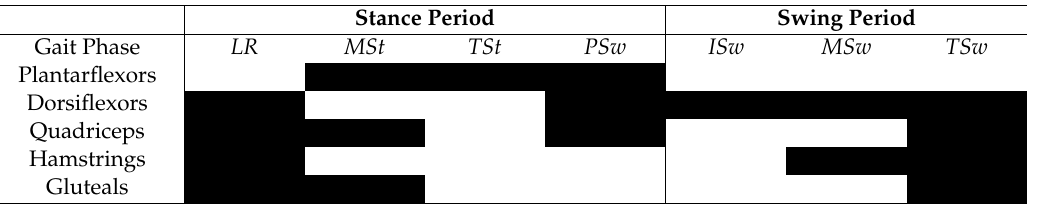
Table 1. Stimulation program based on typical muscle firing patterns during gait [30]. Black boxes illustrate when the muscle groups were stimulated during the gait cycle. LR —Loading